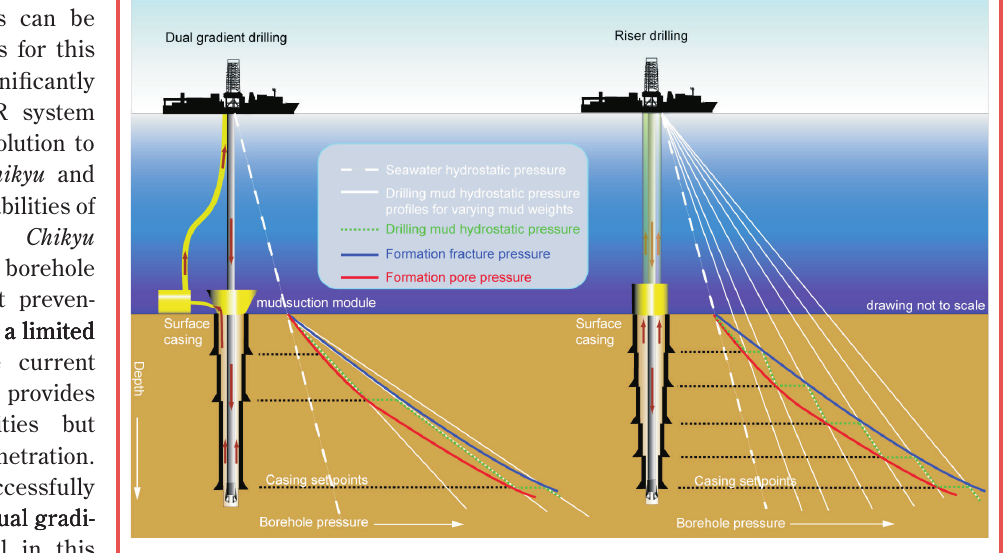
Figure 3. The dual gradient drilling approach establishes the drilling mud hydrostatic gradient at the seafloor which allows for the use of heavier drilling muds with an advantageous pressure increase with depth. The use of optimized drilling mud provides better well control and fewer casing points by keeping the drilling fluid within the drilling “window” for more depths within the borehole.